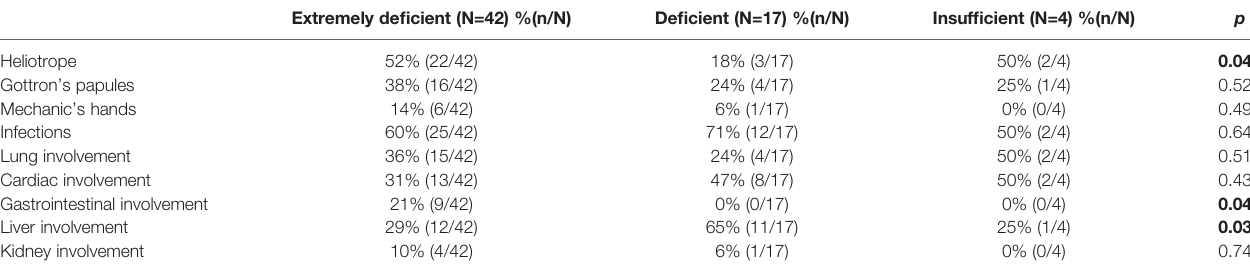
TABLE 3 | Clinical features of IIM patients with extremely de fi cient, de fi cient and insuf fi cient serum levels of 25-(OH)-D. Extremely de fi cient (N=42)